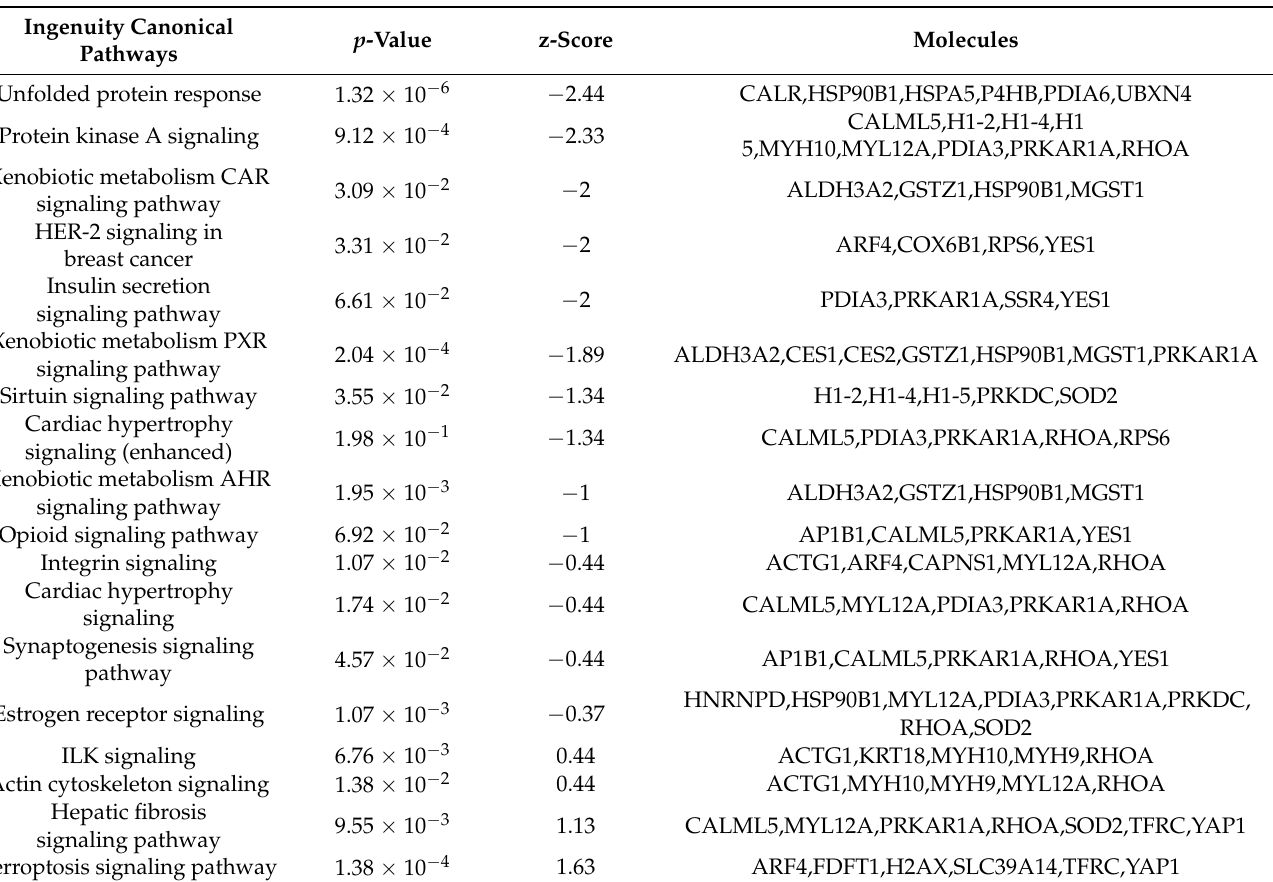
Table 2. Canonical pathways modulated in NAFLD versus control